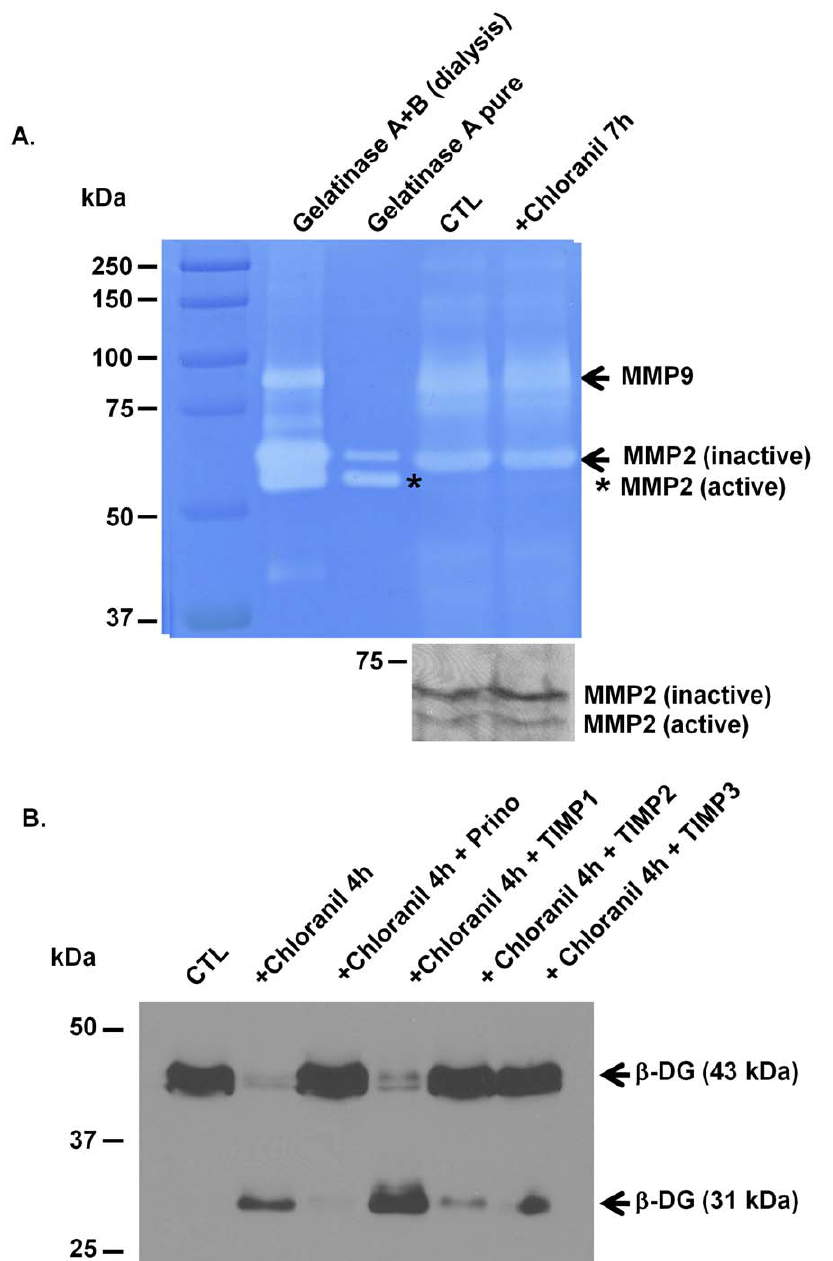
Figure 7. Gelatin zymography and the effect of tissue inhibitors of metalloproteinaseson the chloranil-induced shedding of dystroglycan. A. Primary astrocytes were incubated in the absence or the presenceof 25 m M chloranil for 7 h. Media samples were collected and analyzed by SDS-PAGE gelatin zymography. Note the clear bands against the blue background with an apparent molecular weight of , 92 and , 72 kDa, representing gelatinolytic activity of MMP-9 and MMP-2, respectively. The chloranil does not modulate the amount of MMP-2 and 9 or their activation state. B. Primary astrocytes were incubated for 4 h with 25 m M chloranil alone, 25 m M chloranil with 30 m Mprinomastat, 25 m M chloranil with 110 nM TIMP1, 25 m M chloranil with 100 m M TIMP2 or 25 m M chloranil with 100 m M TIMP3. Protein extracts were loaded (30 m g/lane) and immunoblotted for ß-DG. Note that the chloranil-mediated shedding of ß-DG is inhibited by prinomastat, TIMP2and TIMP3 but not TIMP1.